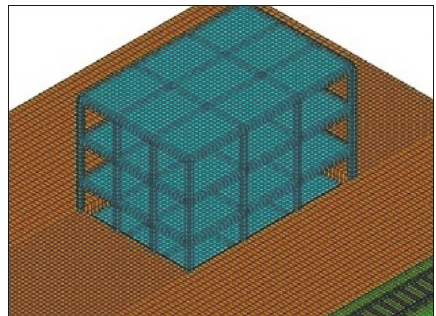
Figure 2: Detailed view of the FEM numerical